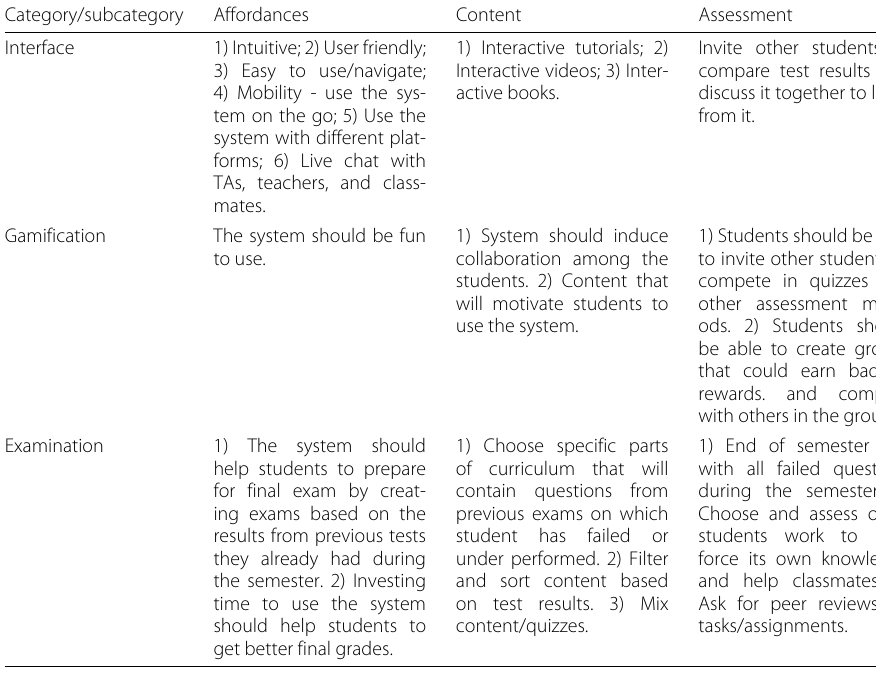
Table 1 Affinity diagram composition before interacting with ProTuS Category/subcategory Affordances Content Assessment